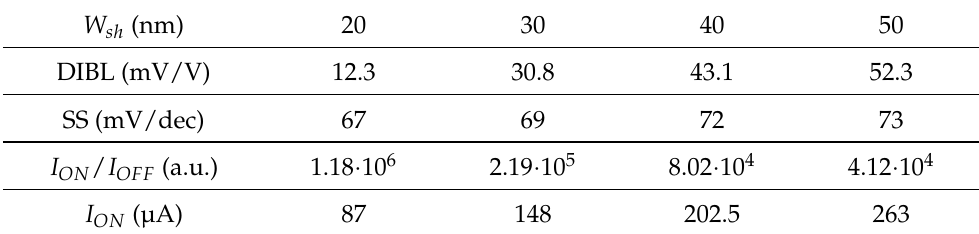
Figure 2. Parametric n-NS-GAAFET transcharacteristics I DS ( V GS ) in semi-logarithmic scale with different nanosheet width W sh values; the inset shows the corresponding I ON /I OFF ratios. Table 3. Calculated FoM for each considered NS width W sh